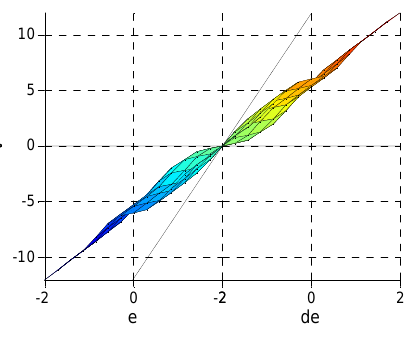
Fig. 7. Control surface of a PDFLC.